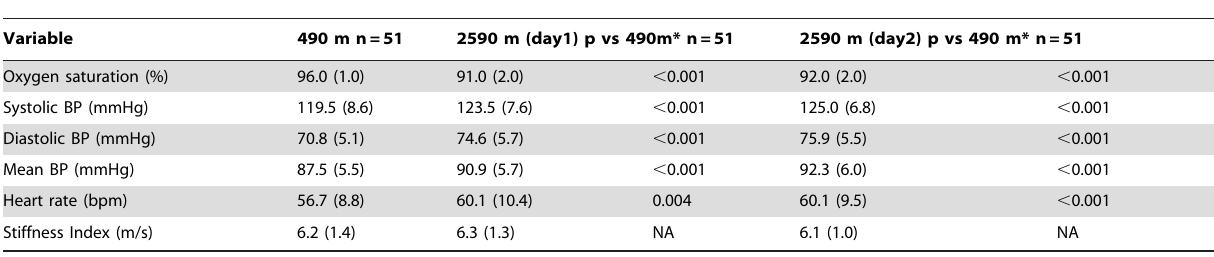
Table 1. Effects of moderate altitude on oxygen saturation and vascular